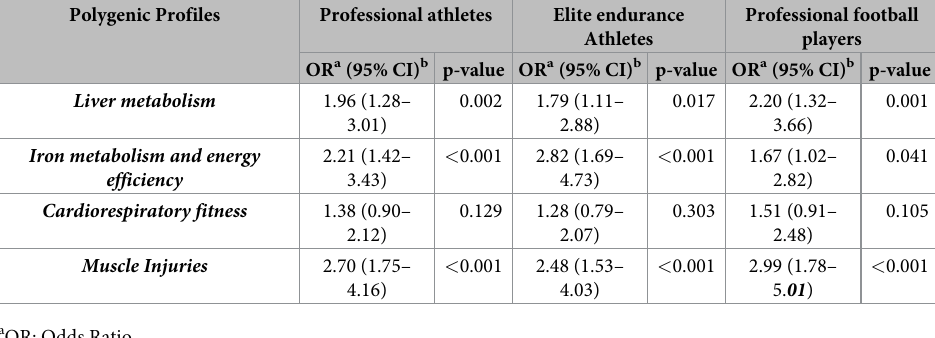
Table 5. Prediction values of polygenic profiles of being professional athletes, elite endurance athletes and profes- sional football players. Polygenic